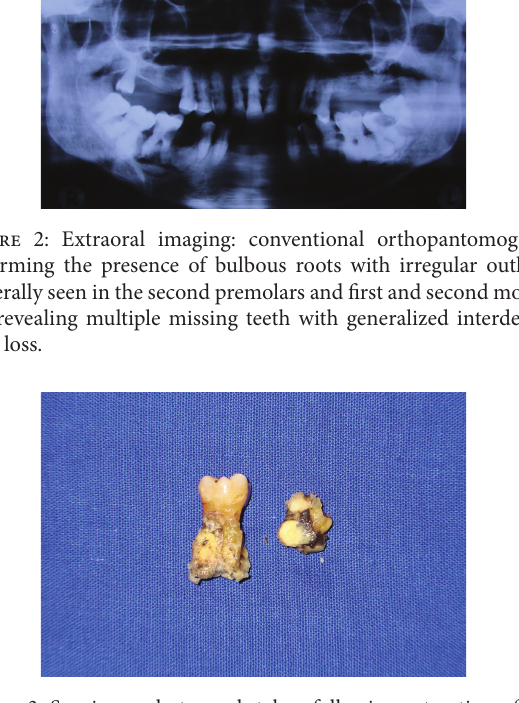
Figure 3: Specimen photograph taken following extraction of the carious first molar and the root stump of the second premolar, with irregular, yellowish calcified material on the root surface.